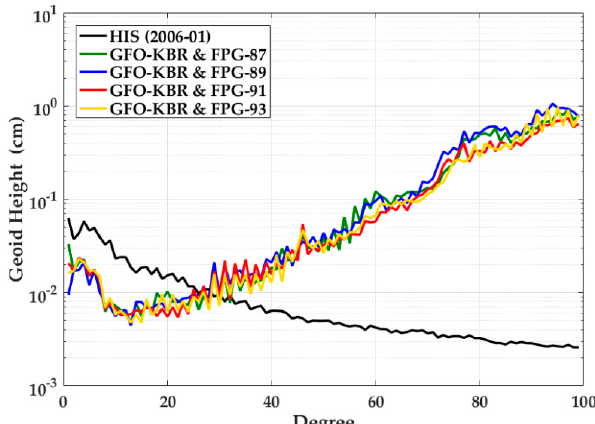
Table 4. Error reduction rate (ERR) of different GFO-KBR & FPG combined models with respect to